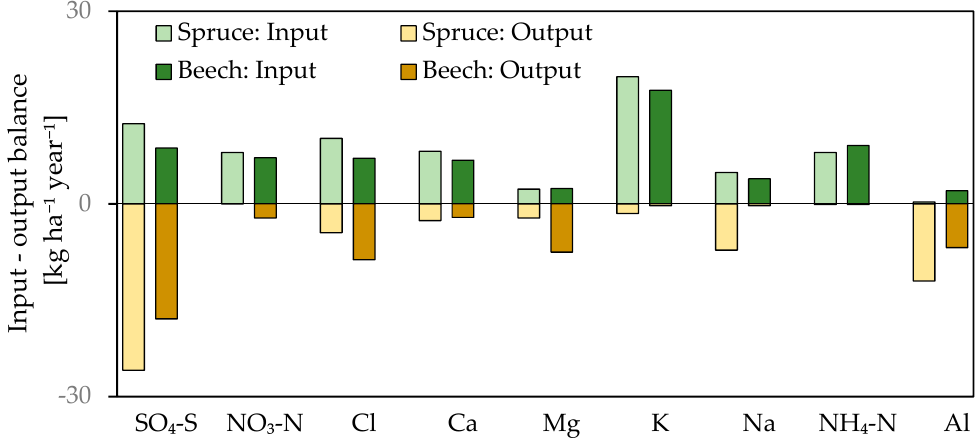
Figure 9. Input–output element budgets for the spruce and the beech stand. Inputs are represented by THF (+STEM) deposition, and outputs are calculated as fluxes passing the 90 cm horizon. Outputs were reversed to show element balances.